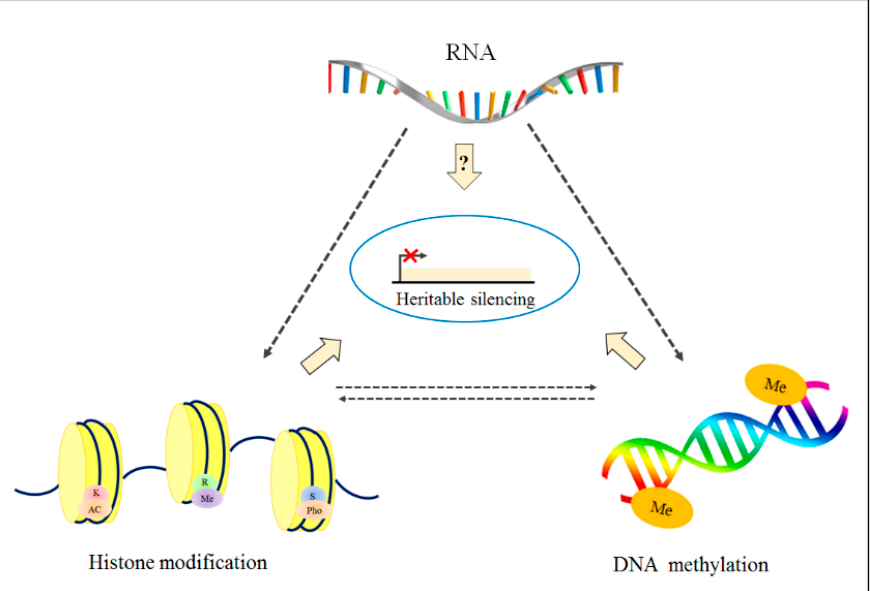
Figure 5. The connection between RNA, histone changes, and the heritable quieting of DNA meth- ylation. Histone deacetylation and other changes in histones, speci fi cally the methylation of